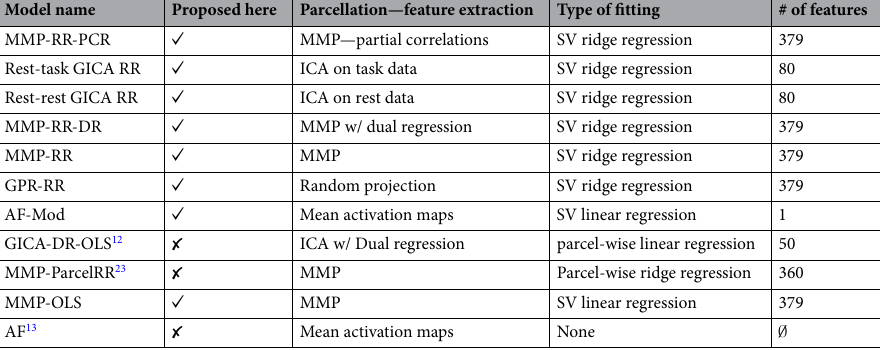
Table 1. An overview of all methods we compare and benchmark. The names are composed of parts for feature extraction ( MMP , PCR , GPR , GICA , AF ) and regression model (RR, OLS), see “Materials and methods” section for